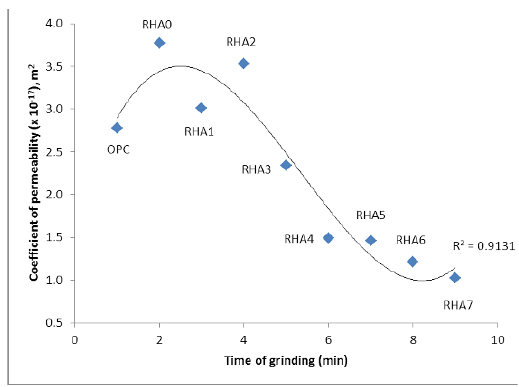
Figure 7. Permeability of OPC and RHA at varying grinding time at 7 days.